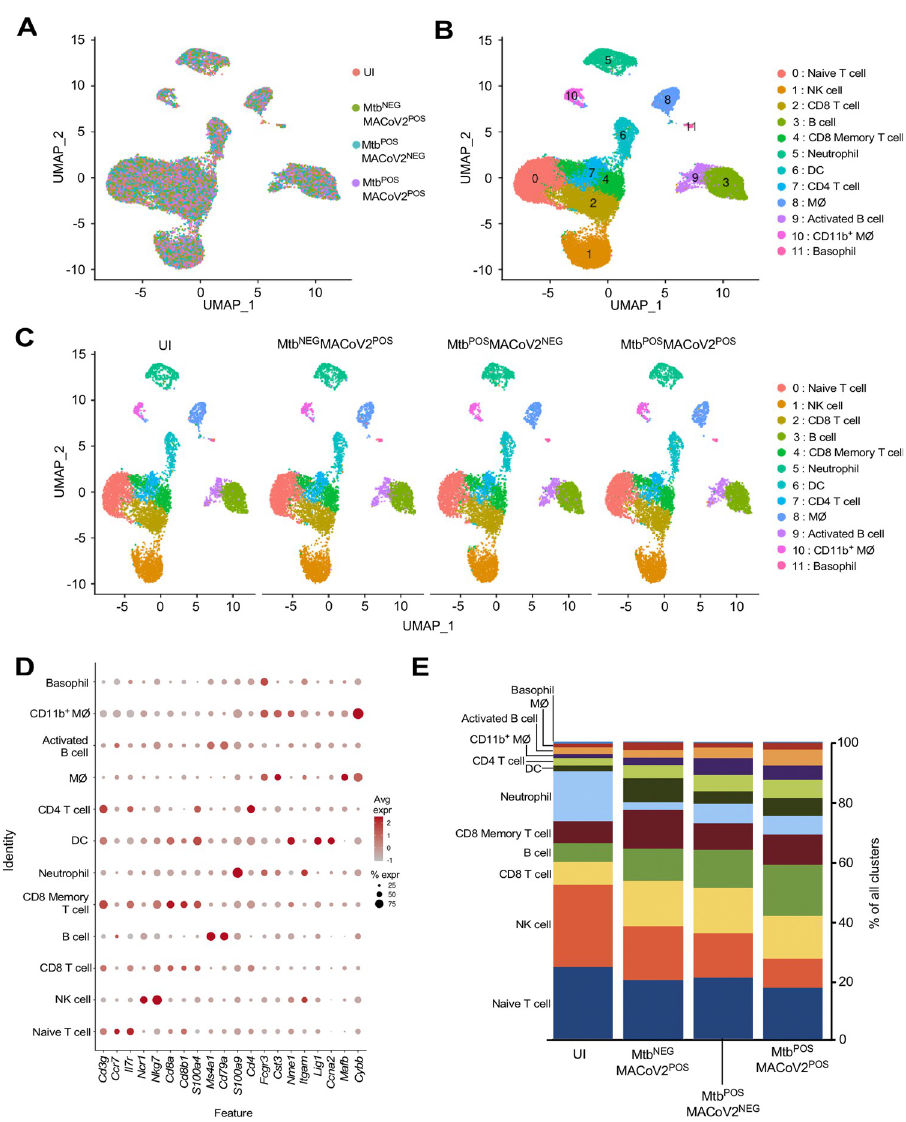
Fig 5. Lung T and B cell subsets expand upon challenge of Mtb POS mice with MACoV2. As an unbiased means to define and compare the lung immune landscape, live CD45+ cells were purified from the lungs of four experimental groups (Uninfected, UI; Mtb NEG MACoV2 POS ; Mtb POS MACoV2 NEG ; Mtb POS MACoV2 POS ) on post-challenge Day 7 and used for scRNA analysis. ( A-C ) t-SNE plots of the resulting data, either ( A-B ) pooled across groups or ( C ) segregated by group to show ( A ) the extent of overlay and ( B-C ) clustering of data into 12 immune lineages. ( D ) The distribution and expression patterns of lineage defining genes which we used to annotate each cluster, as pooled from all group data (individual group data are shown in S1 Fig ). ( E ) The proportion of each immune lineage in the lungs of each experimental group. M Ø , macrophage; DC, dendritic cell; NK, natural killer.